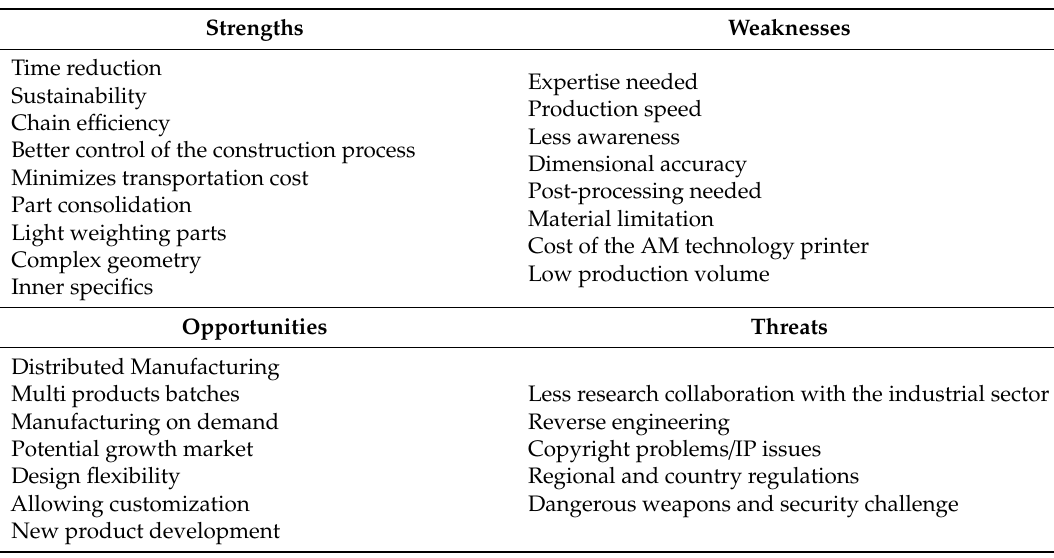
Table 3. AM in the medical fields—SWOT